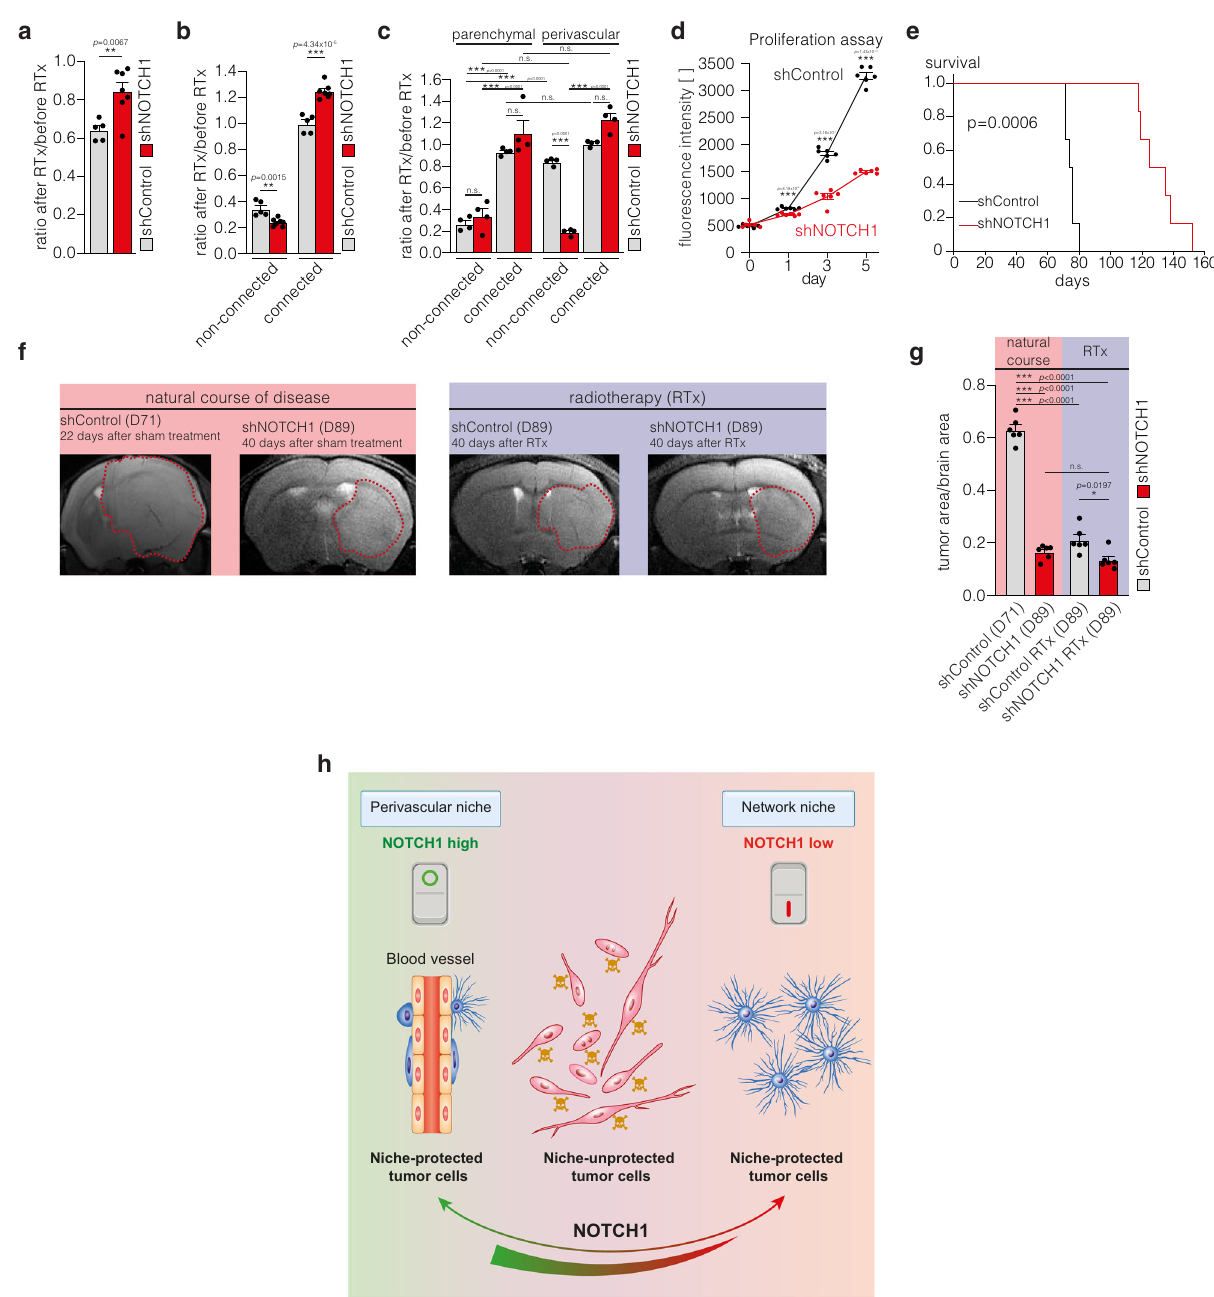
Fig. 8 NOTCH1 downregulation sensitizes perivascular glioblastoma cells to radiotherapy, but induces network resistance. a , b Ratio of cell counts 7 days after and before irradiation of S24 shControl and shNOTCH1 tumors ( n = 5 regions (S24 shControl)/7 regions (S24 shNOTCH1) in 3 mice per group, two-tailed t -tests). c Subgroup analysis of the ratio of cell counts of S24 shControl and shNOTCH1 cells 7 days after and before irradiation categorized regarding connectivity and compartment ( n = 4 regions in 3 mice per group, one-way ANOVA ( p = 9.09 × 10 − 14 ), Tukey ’ s post hoc test). d AlamarBlue proliferation assay of S24 shControl and shNOTCH1 cells ( n = 6 biological replicates, two-tailed t -tests). e Survival analysis of S24 shControl and shNOTCH1 tumor bearing mice ( n = 6 mice per group, two-sided log rank test). f Exemplary 9.4 T MRI images of S24 shControl and shNOTCH1 tumors. Left: natural course, right: 40 days after irradiation (RTx). g Quanti fi cation of tumor burden (tumor area/brain area on 9.4 T MRI) in untreated and irradiated mice ( n = 6 mice per group, one-way ANOVA ( p = 6.18 × 10 − 15 ), Tukey ’ s post hoc test). h Graphical abstract of the two niches of resistance in glioblastoma. The perivascular niche (PVN) (left) is sustained by the NOTCH1 pathway, whereas low NOTCH1 expression leads to depletion of the perivascular niche and the induction of resistant multicellular networks (right). Non-connected, parenchymal cells (middle) in contrast are sensitive to cytotoxic therapies. Data a – d , g are represented as mean + SEM. * p < 0.05, ** p < 0.01, *** p < 0.001, n.s. = not signi fi cant. Source data are provided as a Source Data fi